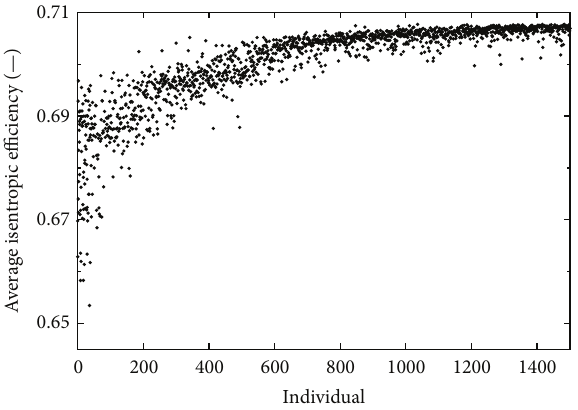
Figure 11: Average isentropic efficiency for each